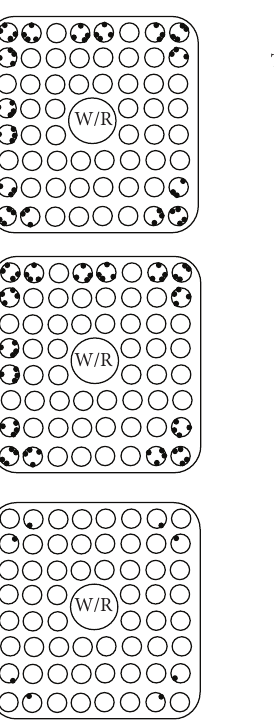
F 1: �e�nition of thermocouple position for assembly C2A